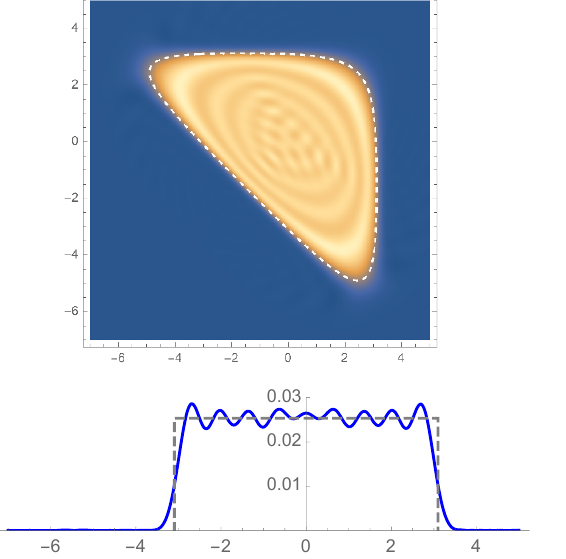
Figure 5 . The same plot for local P 2 for N= ~ = 1 = 2 (cid:25) . Here, N = 10. On the bottom plot, we show the restrictions of the Wigner distribution on the slice p = 0, together with the classical limit in